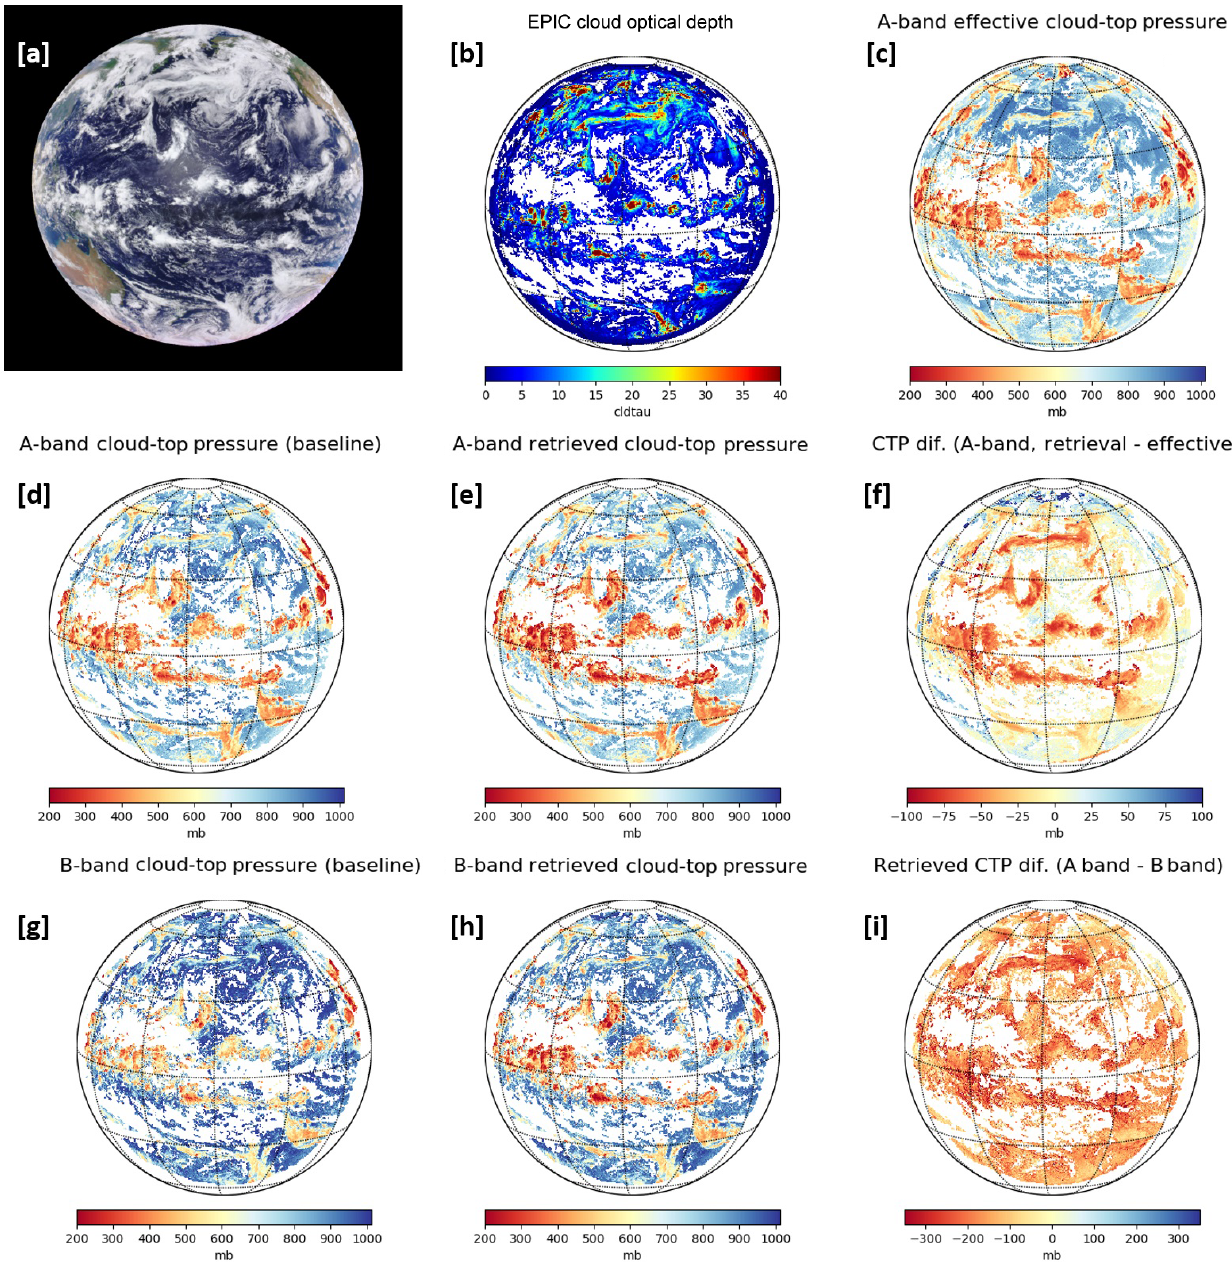
Figure 8. (a) RGB image from a DSCOVR EPIC measurement at 00:17:51GMT on 25 July 2016; (b, c) COD (liquid assumption) and A-band effective CTP from NASA ASDC EPIC L2 products. (d, e) Baseline and retrieved CTP derived from EPIC A-band measurement; (f) the difference of the A-band retrieved CTP and A-band effective CTP. (g, h) Baseline and retrieved CTP derived from EPIC B-band measurement; (i) the difference of retrieved CTP between the EPIC A band and B